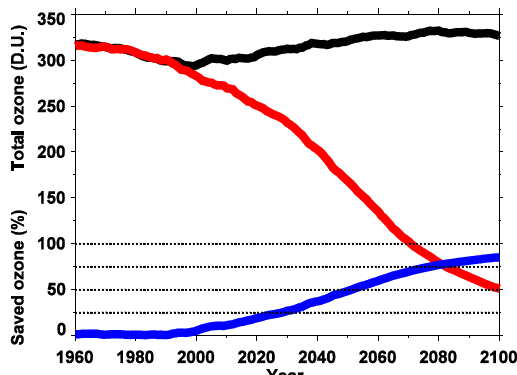
Fig. 6. Time evolution of the global and annual mean total ozone for the reference (black) and no Montreal protocol (red) simula- tions. Total ozone saved by the Montreal Protocol limitations (%) is represented by the blue